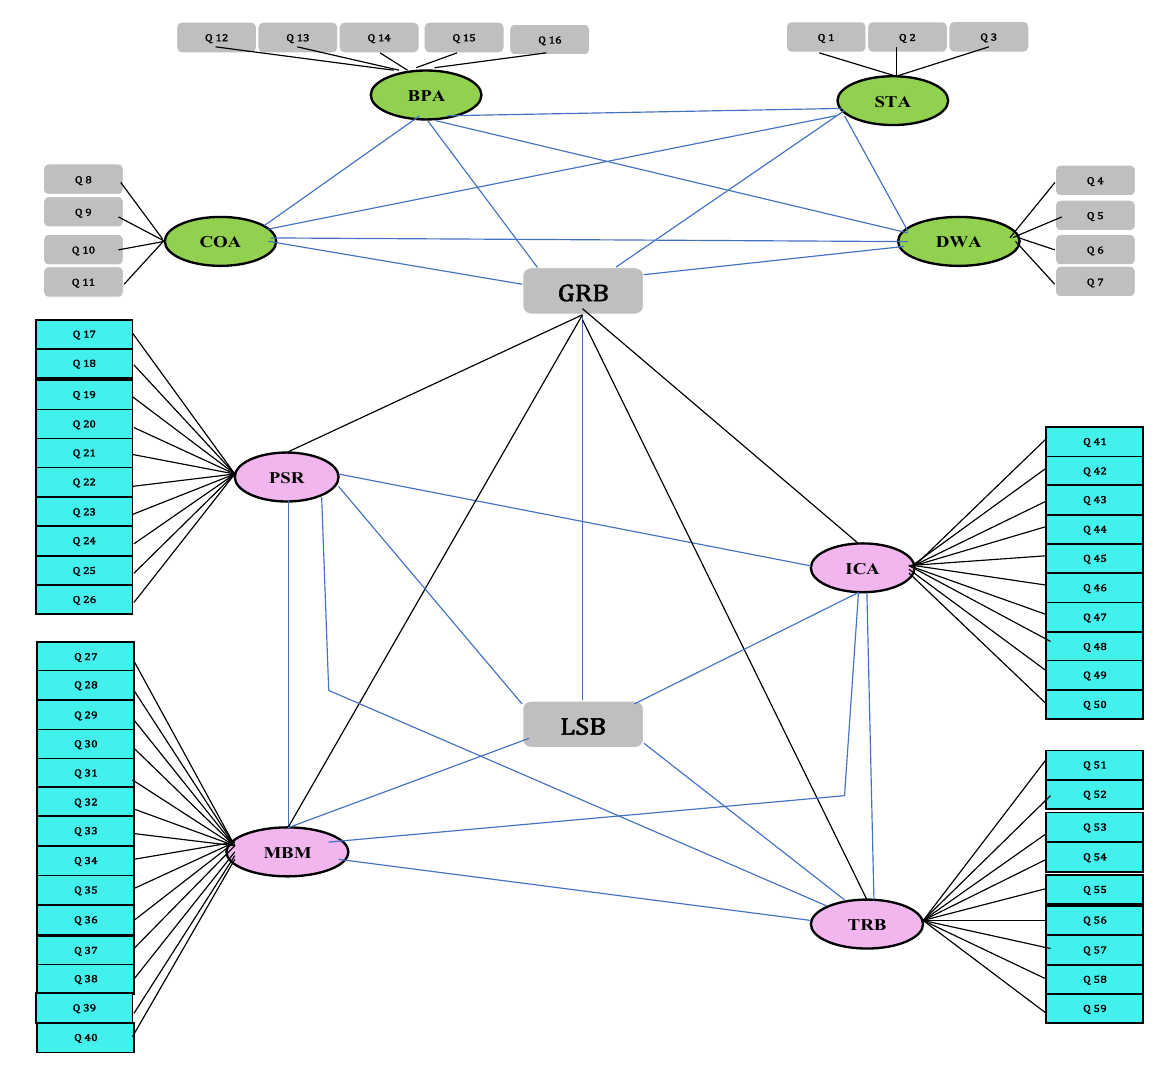
Figure 1. The Conceptual model of research.